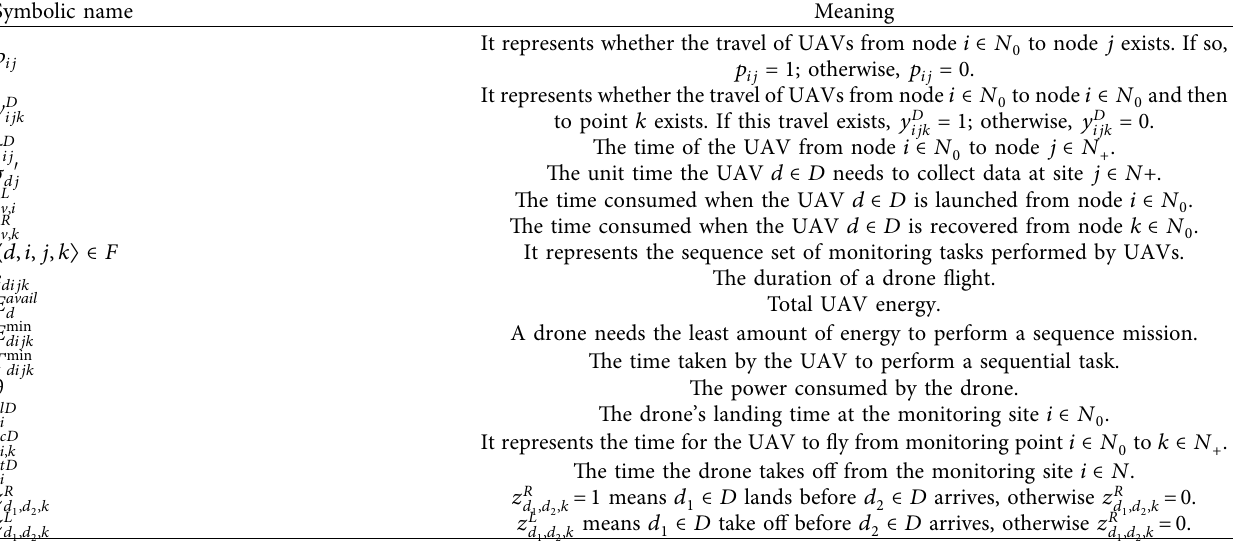
Table 2: Te symbol and variable table for